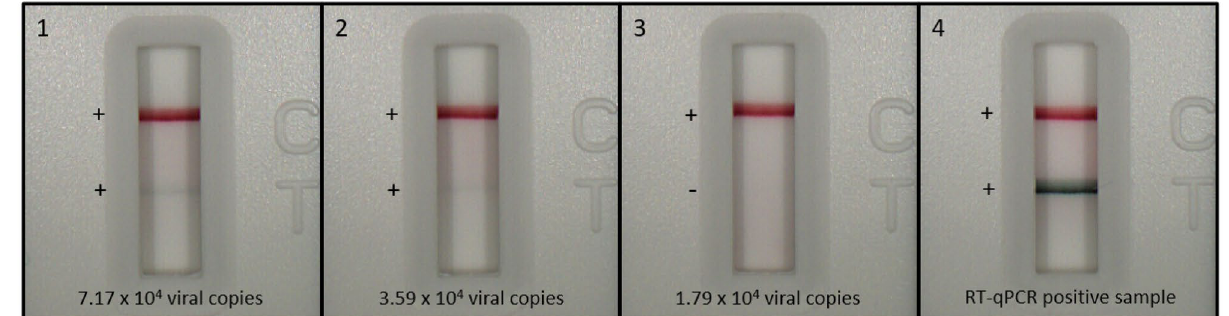
Figure 6. Representative RDT cassettes of each level of inactivated virus-spiked negative nasal swab samples at or around the LOD alongside an RT-qPCR positive swab sample. Weak positive blue test lines are visible in the “T” location of cassettes 1 and 2, both at and above 3.59 × 10 4 viral copies/RDT. No test line is visible on cassette 3, below 3.59 × 10 4 viral copies/RDT. For comparison, the RT-qPCR positive swab sample demonstrates a clearly visible test line on cassette 4 from a highly positive patient sample. Control lines are visible at location “C” for all cassettes